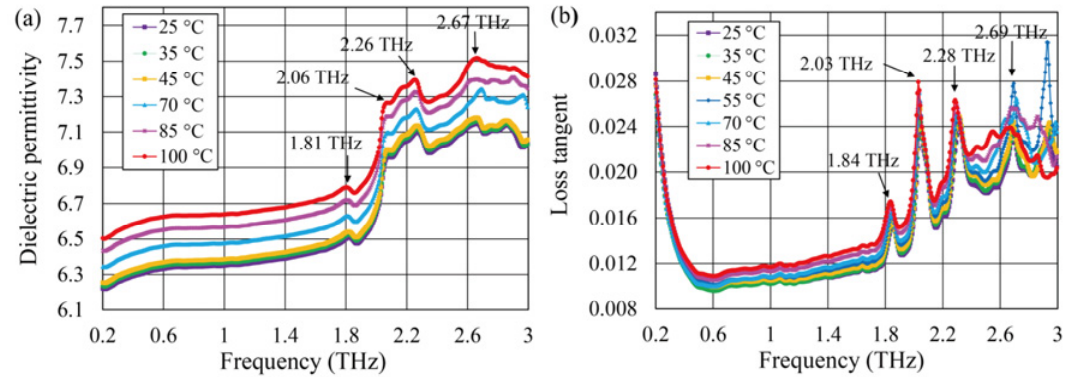
Fig. 10 Dielectric permittivity (a) and loss tangent (b) versus frequency in the range of 0.2–3 THz for a few temperatures in the range of 25–100 ℃ for Li 2 WO 4 ceramics doped with 4% AlF 3 –CaB 4 O 7 , sintered at 600 ℃